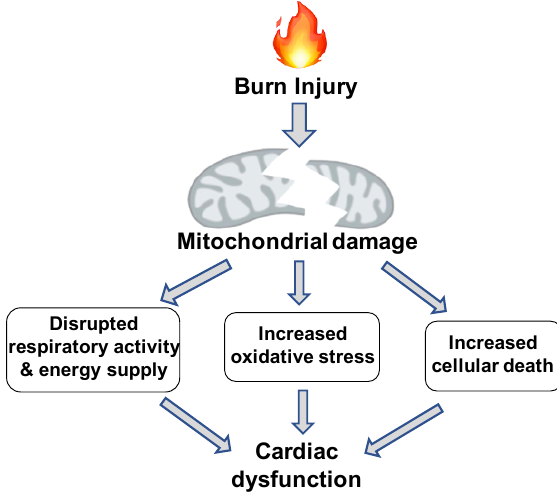
Figure 1. Schematic of burn-induced cardiac mitochondrial pathological alterations.